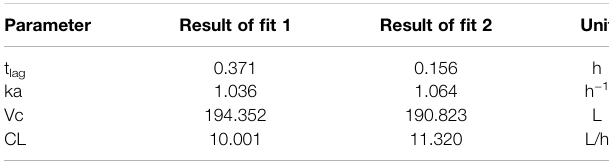
TABLE 2 | PK parameter values obtained by model fi tting in Fit 1 and Fit 2.